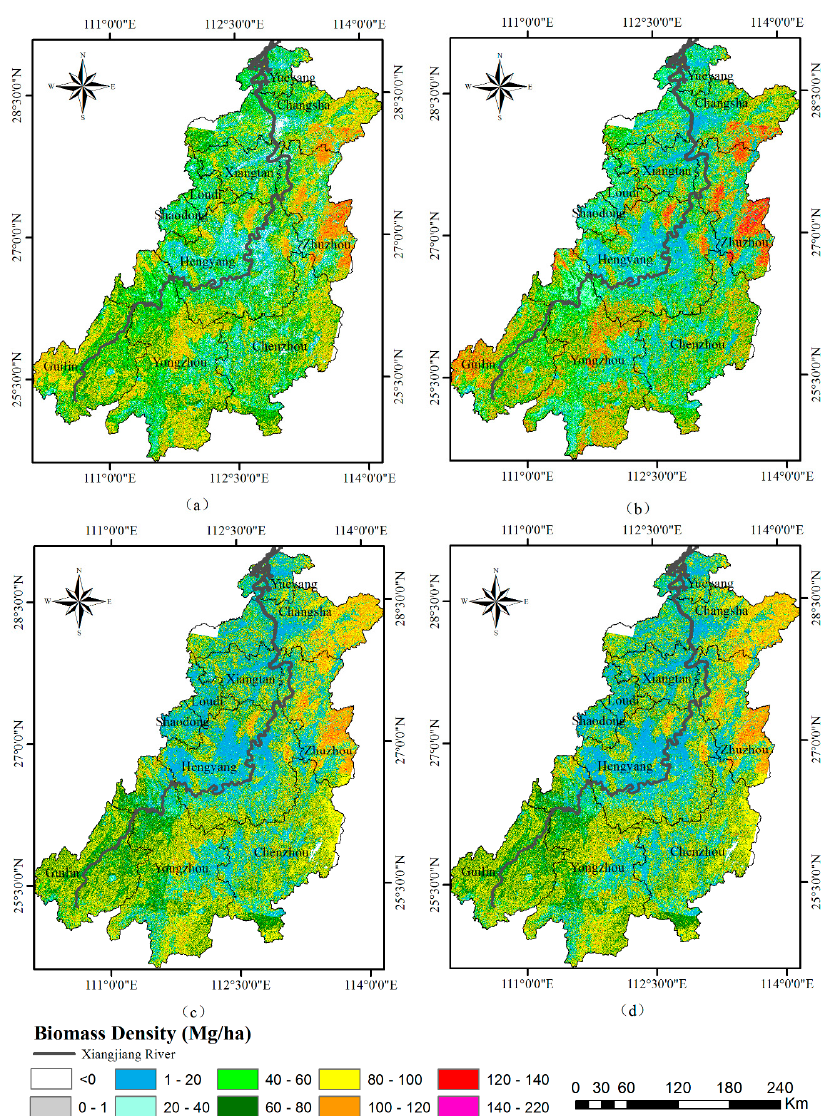
Figure 6. Spatial distributions, that is, maps of above-ground biomass density (AGB) predictions for the basin by: ( a ) the multivariate linear regression (MLR); ( b ) the logistic regression (LR); ( c ) the g-kNN with k = 10; and ( d ) the CW-kNN with k = 10.